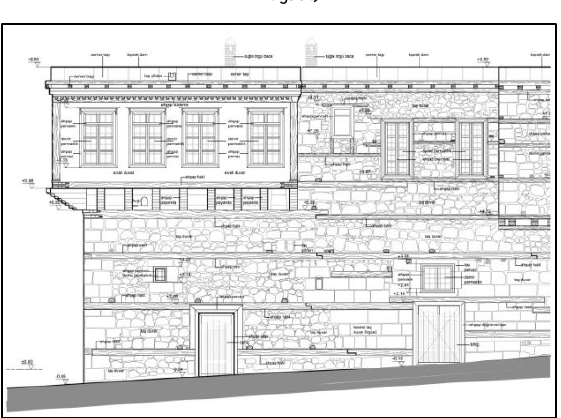
Figure 21. Northern View - Facade Detail (Restoration